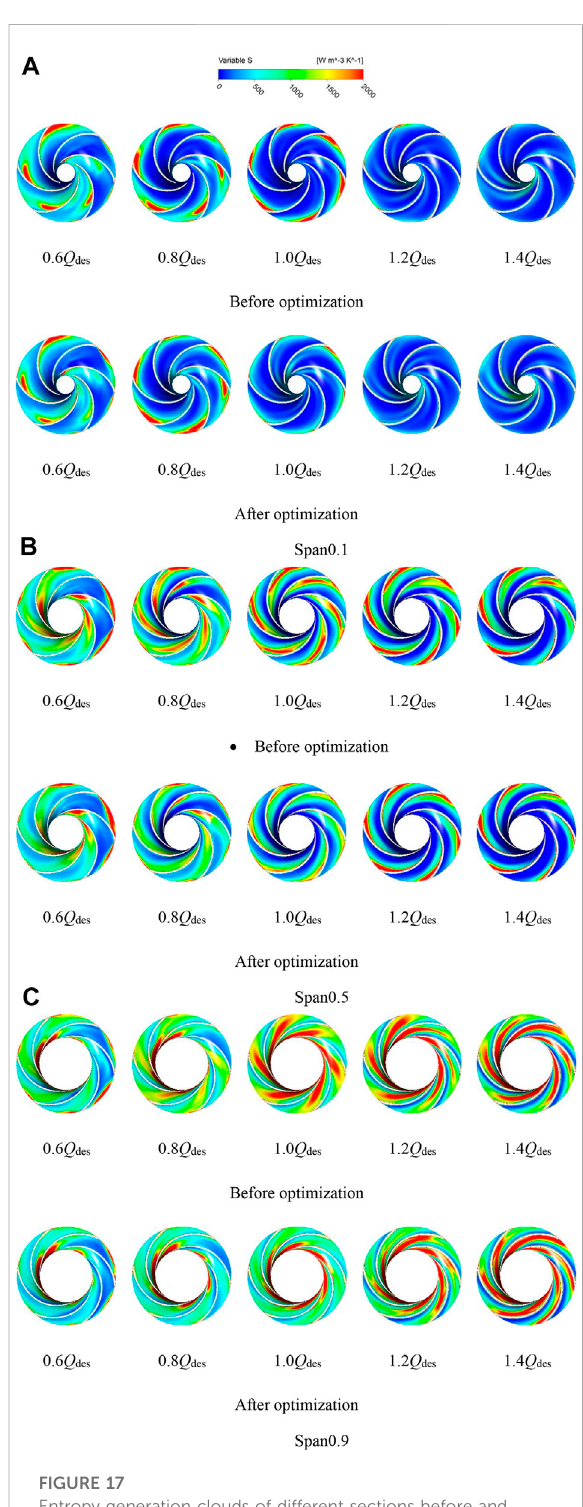
FIGURE 17 Entropy generation clouds of different sections before and after optimization. (A) Span0.1, (B) Span0.5, (C)